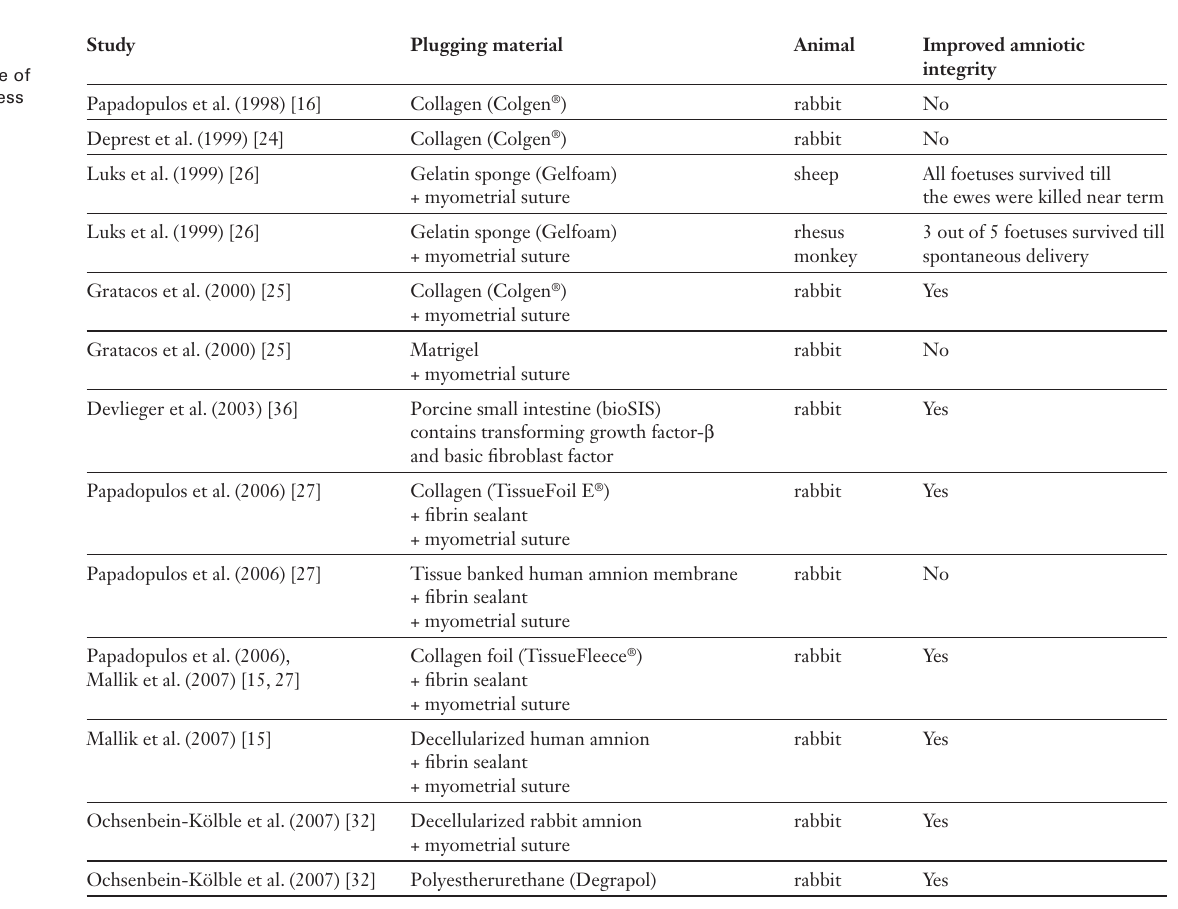
Plugs for closure of foetoscopic access sites.